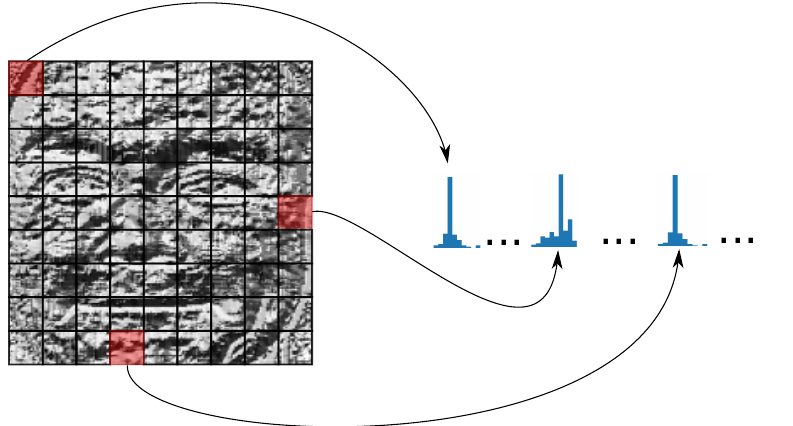
Figure 3. LBP feature extraction.